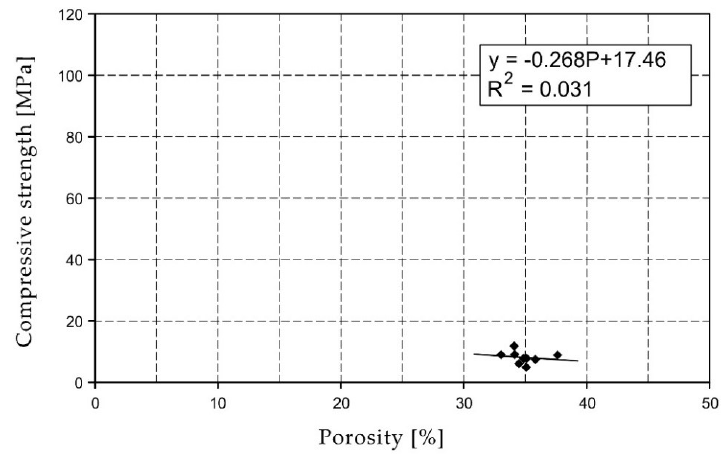
Figure 12. Compressive strength of O07XX series bricks.